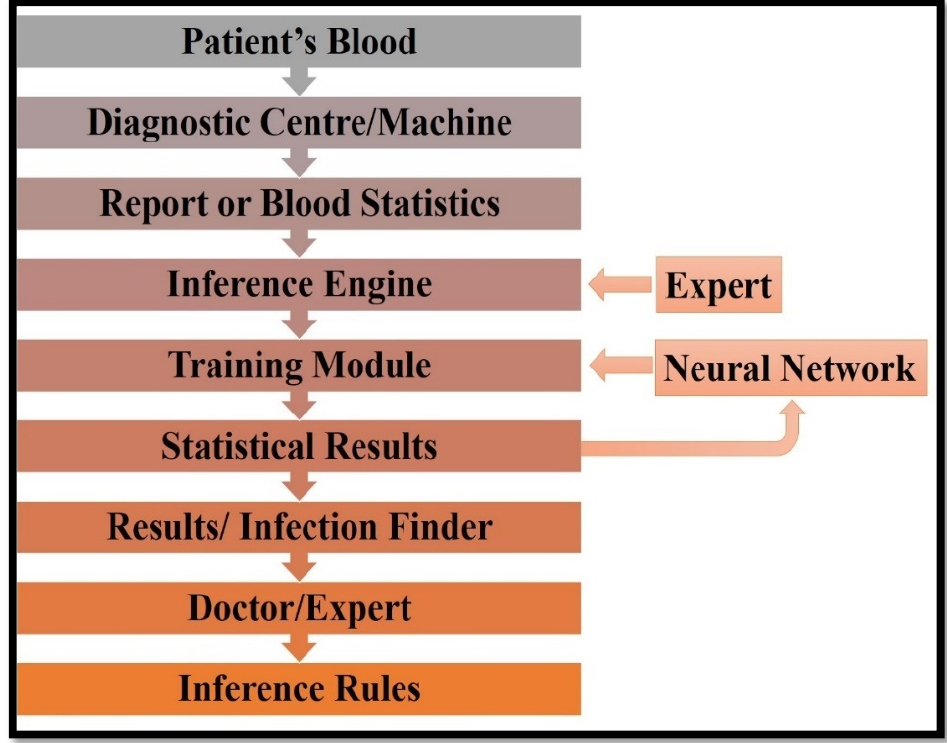
Figure 5. Proposed system model and flow process [41,42].